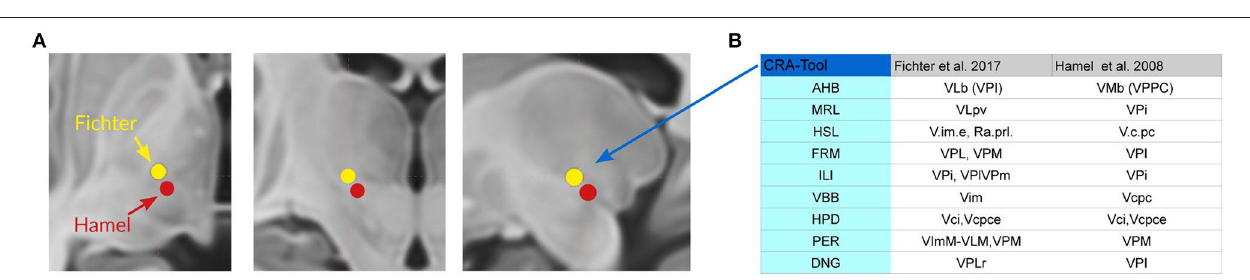
FIGURE 12 | Active deep brain stimulation (DBS) sites in tremor patients from two studies (Hamel et al., 2007; Fiechter et al., 2017) attributed to the VIM region. (A) Positions of the DBS stimulation sites in the MNI space. The coordinates of the DBS target in MNI space for Fiechter et al. (yellow) x = 14.3mm, y = − 17.40mm, z = − 2.17mm and for Hammel et al. (red) y = 12.7mm, y = − 19.6mm, z = − 4.38mm. (B) Anatomical characterization of the targets ( Table 2D ) presented in an analysis tool. Such anatomical characterization is available for each voxel in